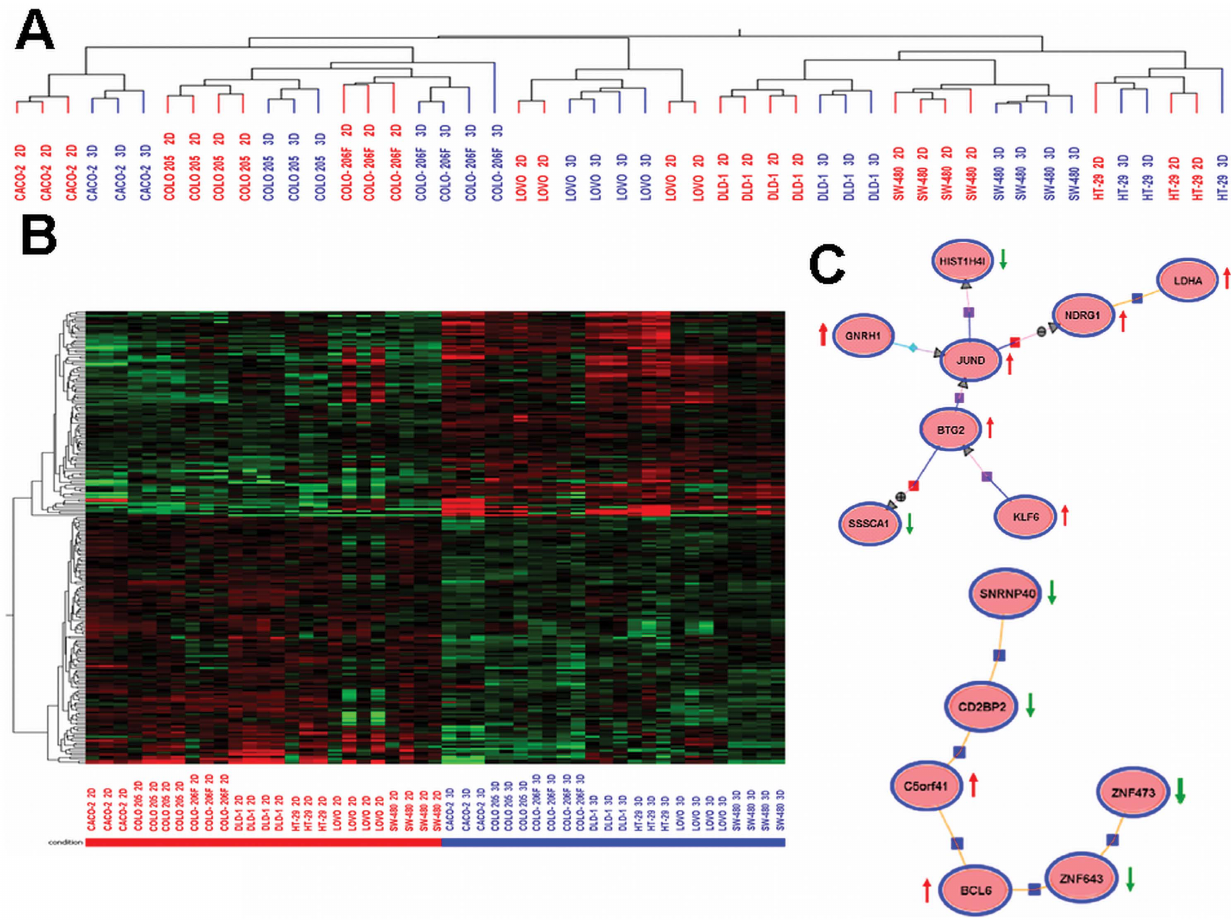
Figure 3. Differential gene expression in 2D and lrECM cultivated cells. A) Hierarchical cluster analysis of 2D and lrECM 3D on-top cultivated CRC cells lines. A total of 23000 transcripts were clustered. Each cell line builds an independent cluster for itself. With the exception for LOVO and HT- 29, within each cell line two separate clusters were observed, due to the cultivation method of the cells: 2D versus lrECM 3D on-top. B) Heatmap of 225 significantly differentially regulated genes between 2D and lrECM 3D on-top cultivated cells. (Mann-Whitney-U test, P corr , 0.05). C) Literature- based network analysis of significantly differentially regulated genes (Natural Language Processor Engine, GeneSpring GX 10.5). Known interactions of 14 from a total of 225 significantly differentially regulated genes are shown. A red arrow indicates the increased expression of each gene in lrECM cultivation conditions while a green arrow indicates a reduced gene expression.